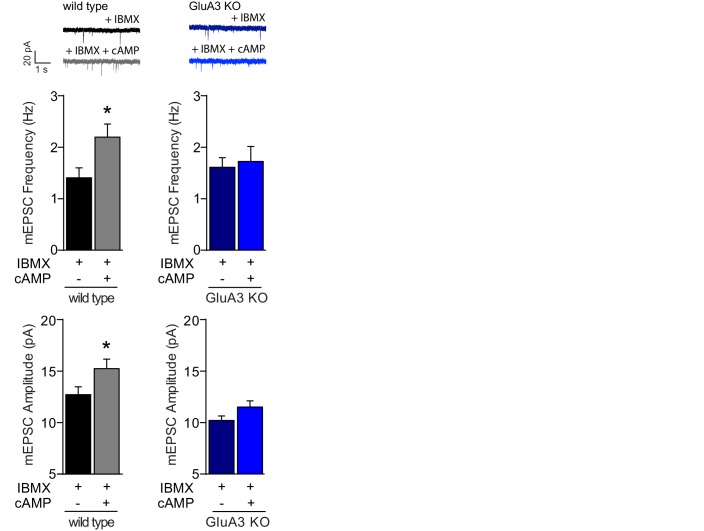
Postsynaptically applied cAMP causes a GluA3-dependent synaptic potentiation.Example traces, mEPSC frequencies and mEPSC amplitudes in the presence of IBMX of WT neurons with (n=10) or without (n=11) cAMP and of GluA3-KO neurons with (n=8) or without (n=8) cAMP in recording pipette. In WT neurons cAMP/IBMX caused increased mEPSC frequency (t-test, p=0.02) and amplitude (t-test, p=0.04). In GluA3-KO neurons we observed no significant change in mEPSC frequency (t-test, p=0.8) or amplitude (t-test, p=0.8). Error bars indicate SEM, * indicates p<0.05.